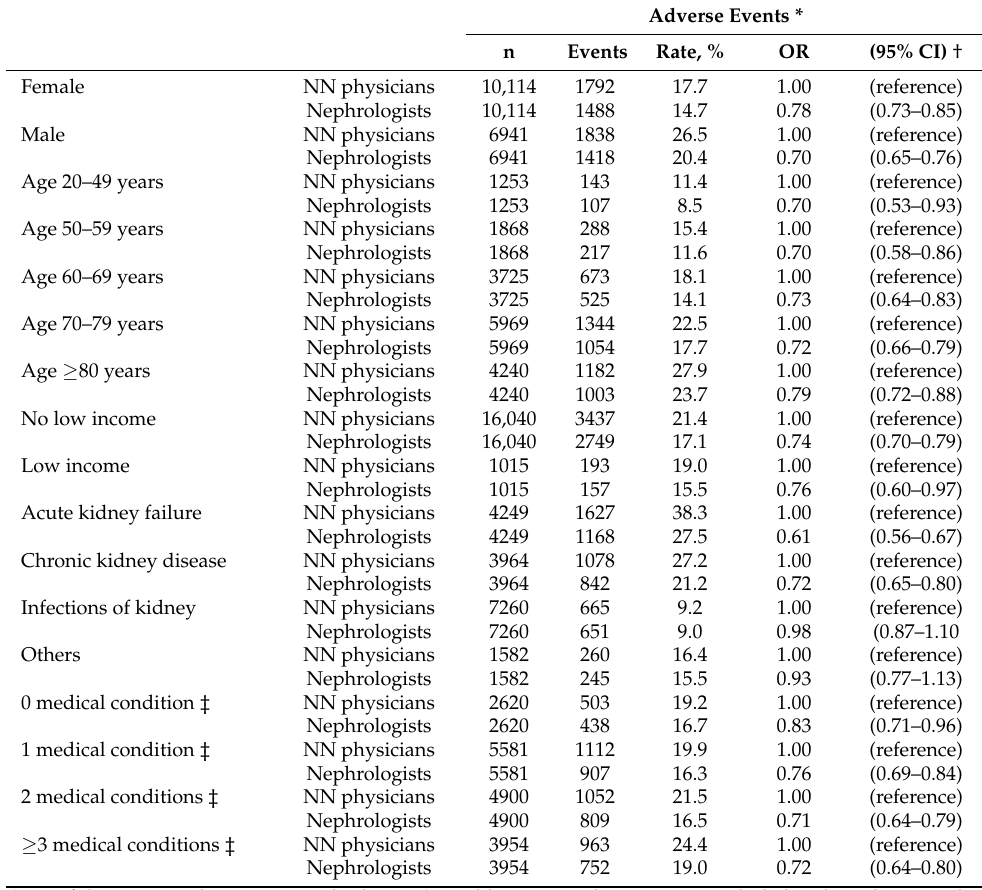
Table 3. The stratified analysis for the adverse events after the admission due to kidney diseases associated with physician specialty.